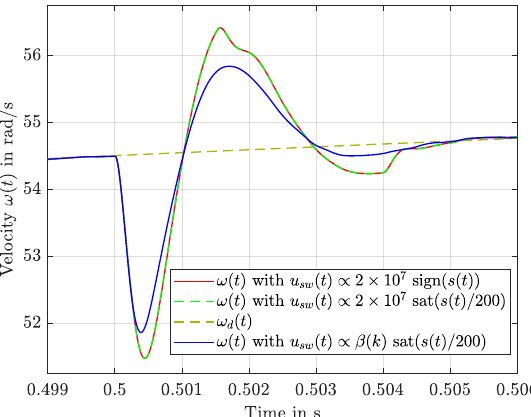
Figure 6. Detailed view of the velocity tracking after load torque